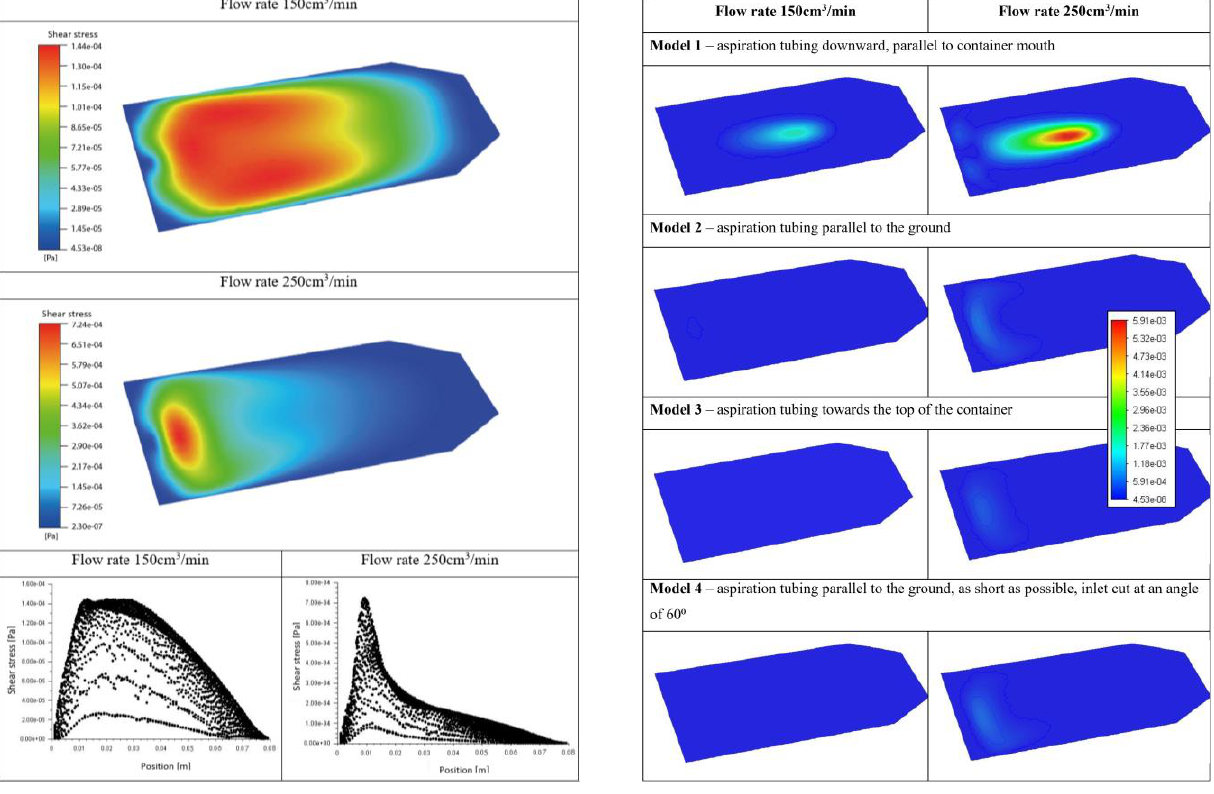
Fig. 7. Maps and diagrams of shear stress distribution on the lower wall of the sampler for model 3